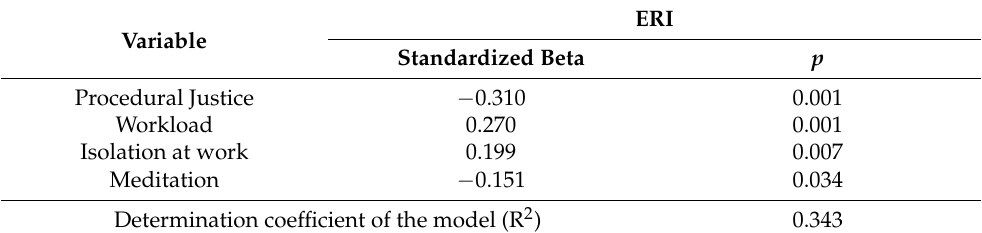
Table 4. Second wave. Stepwise linear regression analysis. Relationship between job changes and perceived work-related stress